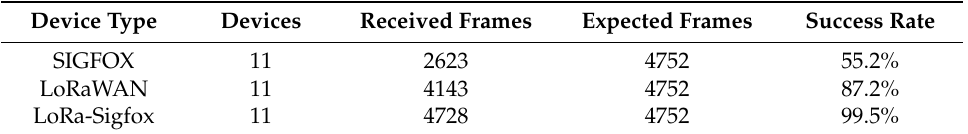
Table 4. Reception rates over a period of 72 h sending data every 10 min (14256 frames).